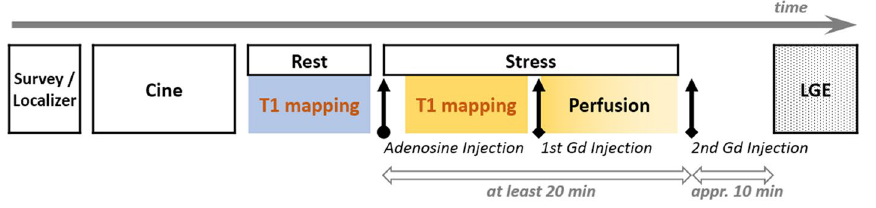
Figure 1. Cardiac magnetic resonance (CMR) examination paradigm for clinical assessment of coronary artery disease (CAD). Scan protocol was shown from survey (left) to LGE (right) in time sequence. Details see text. LGE = late-gadolinium enhancement, Gd = gadolinium.